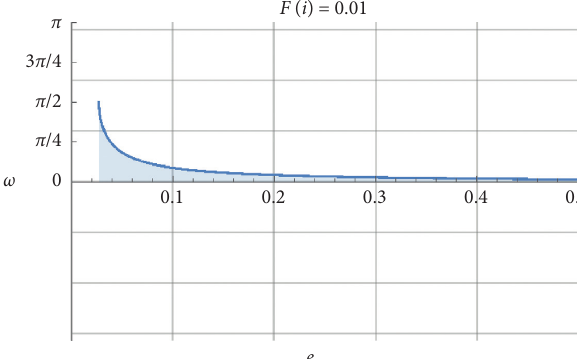
Figure 3: The curve ω ( e ) at which _ e � _ i � 0 for F ( i ) � 0.01.